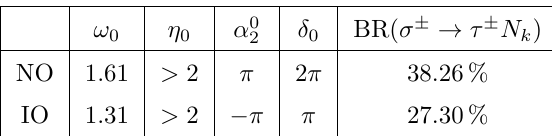
Table 3 . Largest possible branching ratios for the decay of (cid:27) (cid:6) into (cid:28) and N 2 ; 3 . Above the given value for (cid:17) 0 , the branching ratios are to a good approximation independent of this parameter. As can be seen, the IO gives rise to smaller branching ratios compared to